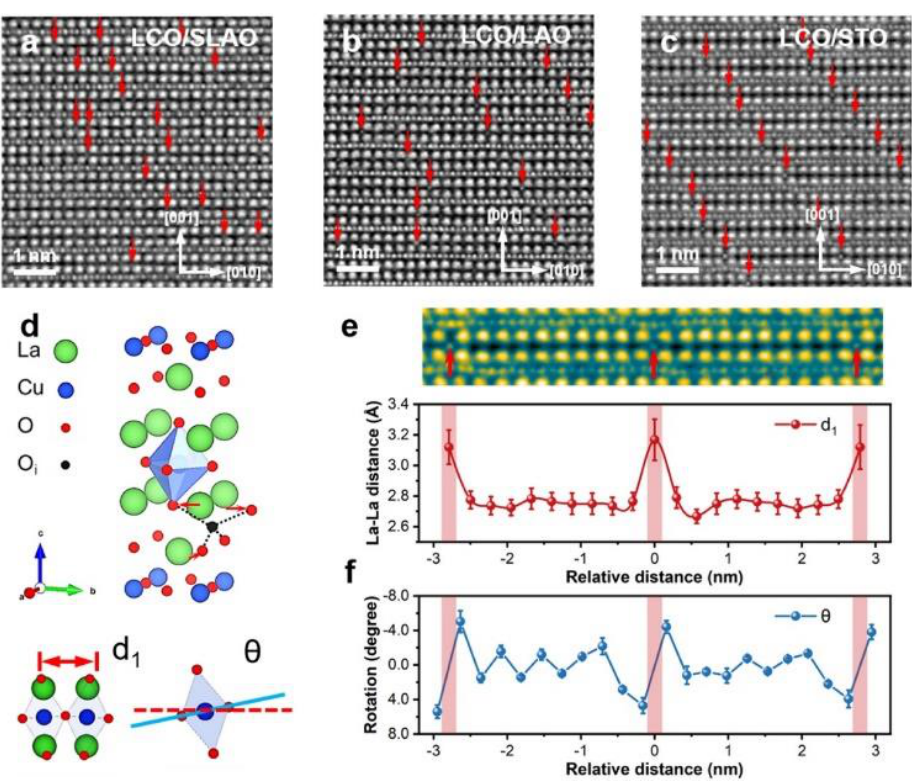
Figure 5. iDPC-STEM micrograph of La 2 CuO 4+ δ deposited on ( a ) SLAO, ( b ) LAO, and ( c ) STO substrates, respectively. Red arrows illustrate the interstitial oxygen atomic columns. ( d ) Schematic structure of La 2 CuO 4+ δ . Only half of the orthorhombic cell is presented. The interstitial oxygen can lead to the slight shift of La and apical oxygen and the CuO 6 octahedra titled. ( e ) The distance (d 1 ) of La–La atomic column spacing and ( f ) the rotation of the CuO 6 octahedra along the b axis vs. the relative distance from the interstitial oxygen. Reprinted with permission from Ref. [53]. Copyright 2022, Elsevier.